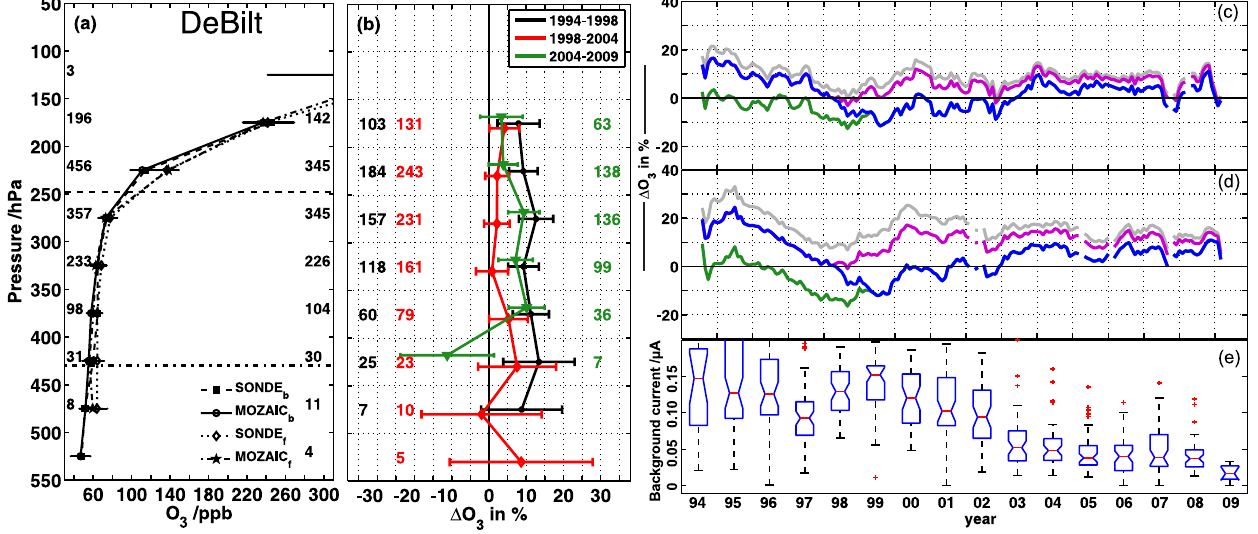
Fig. 4. Comparisons of De Bilt ozonesondes with MOZAIC measurements. (a) and (b) : As for Fig. 3a–b. (c) and (d) : time series of 1 O 3 for the LS (c) and UT (d) , respectively. Time series are shown for the difference resulting from using the operating procedures described in Table 1 (blue line), with no correction for background signal (gray line), with a constant background current correction (green line), and with the application of an altitude-dependent background correction (purple line). (e) : annual statistical distribution of the background current used to process the ozonesonde data. The median is depicted as a horizontal solid red line, the 90% confidence interval as the notches. The box limits correspond to the 75% and 25% quartiles. The whiskers extend out to the maximum or minimum values, or to 1.5 times either the 75% or 25% quartile if there are data beyond this range. Outliers are identified with red